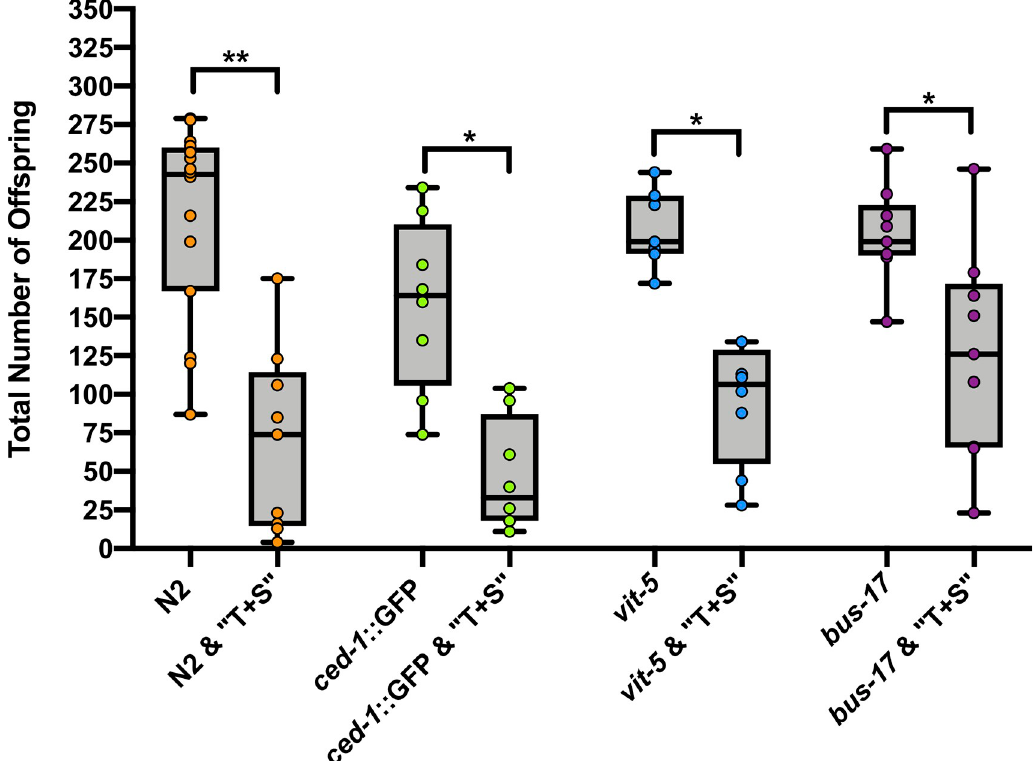
Fig 9. Exposure to “T+S” compromises fertility. Total hatched offspring of wild-type (N2), ced-1 ::GFP, vit-5 , and bus - 17 strains were scored in the presence and absence of pesticide treatment. Each data point (circle) corresponds to total number of F1 progeny from a single animal. Horizontal lines correspond to the median brood size for each data set, and whiskers correspond to range. Total broods scored: wild-type (N2) control, n = 16; wild-type (N2) “T+S”, n = 9; ced-1 ::GFP control, n = 8; ced-1 ::GFP “T +S”, n = 8; vit-5 control, n = 7; vit-5 “T+S”, n = 8; bus-17 control, n = 9; bus-17 “T+S”, n = 9. Significance was determined by a two-tailed Mann Whitney test. Error bars = S.E.M. � denotes p � 0.01. �� denotes p � 0.0001.